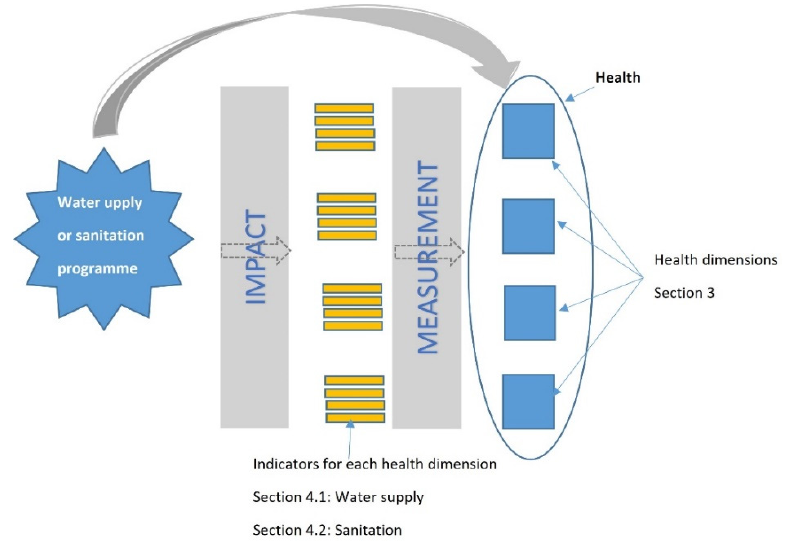
Figure 2. Proposed Methodology for Comprehensive Health Impact Assessment in Water Supply and Sanitation Actions, indicating sections in the paper where information on the dimensions and their indicators can be found.